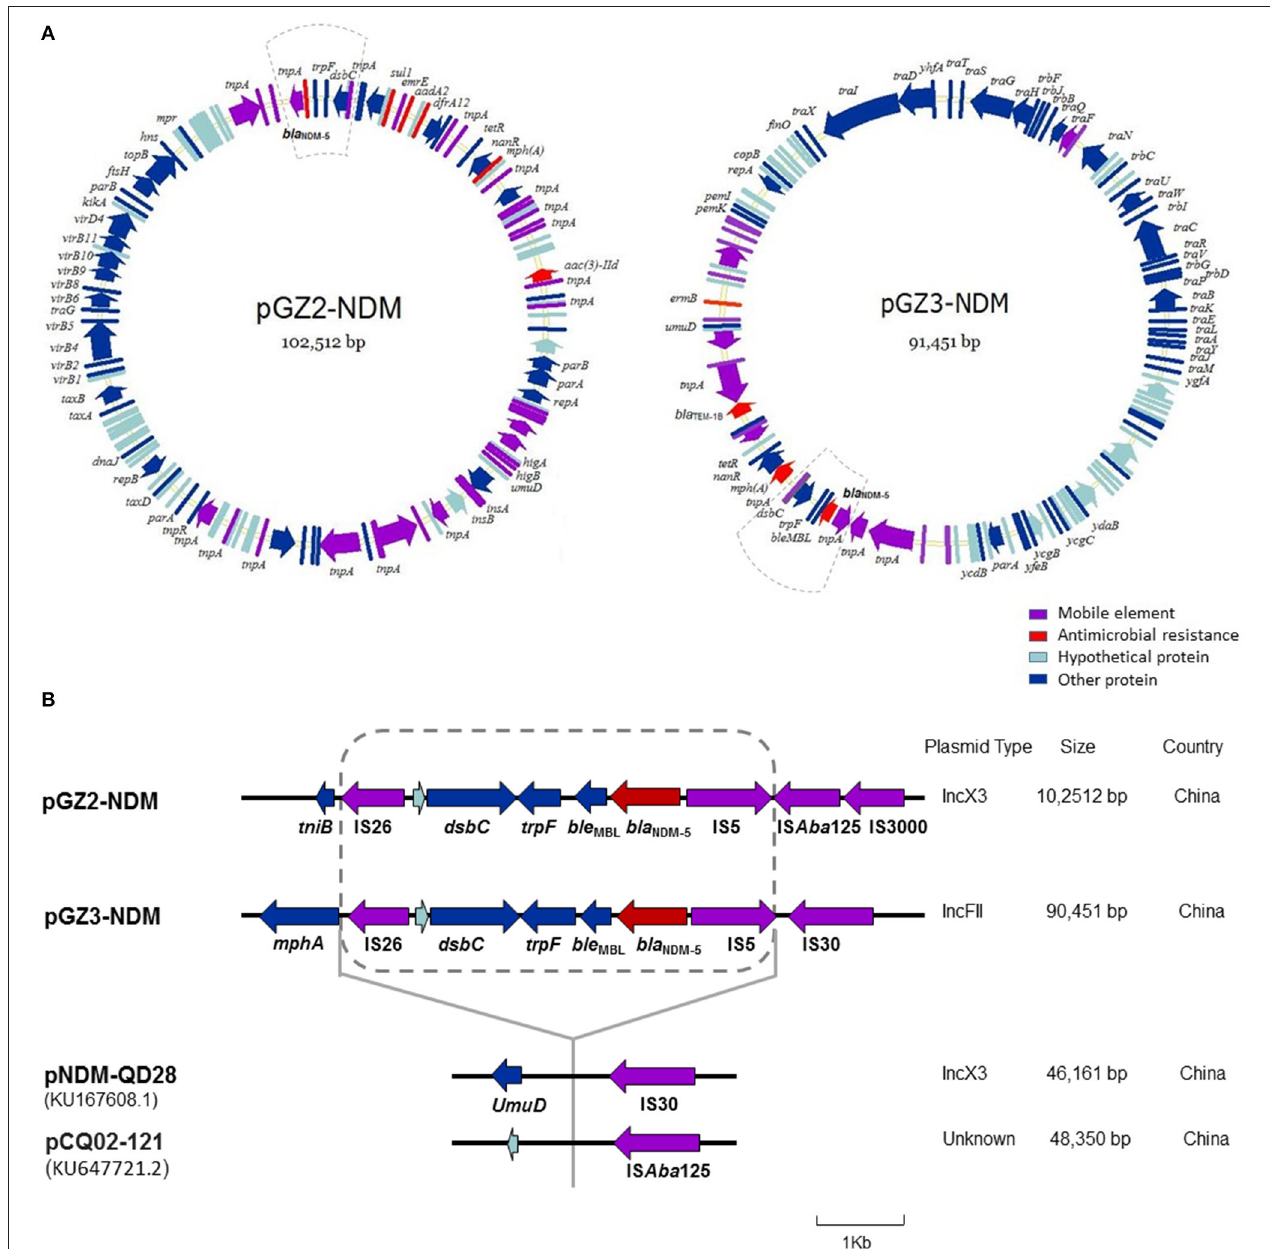
FIGURE 3 | Plasmid analysis of pGZ2-NDM and pGZ3-NDM. Structure map of pGZ2-NDM and pGZ3-NDM (A) and comparative analysis of the genetic contexts of bla NDM - 5 in plasmids reported in this study and previously described (B) . The gene name is shown next to the corresponding arrow or rod. Genetic regions with dashed lines in pGZ2-NDM and pGZ3-NDM are indicated as bla NDM - 5 region. The genetic environment of bla NDM - 5 (with dashed line) in pGZ2-NDM and pGZ3-NDM was similar as that previously described in pNDM-QD28 (GenBank accession KU167608.1) and pCQ02-121 (GenBank accession KU647721.2) with 100% query coverage and 99% identity. However, the regions containing bla NDM - 5 were inserted into different genes and plasmid